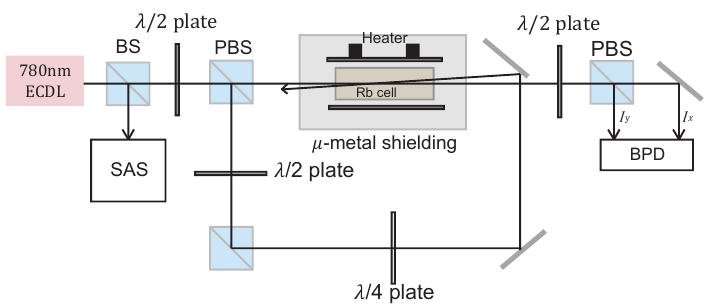
Figure 1. Experimental setup for polarization spectroscopy. External cavity diode laser (ECDL), saturated absorption spectroscopy (SAS), polarizing beam splitter (PBS), beam splitter (BS), and balanced photo detector